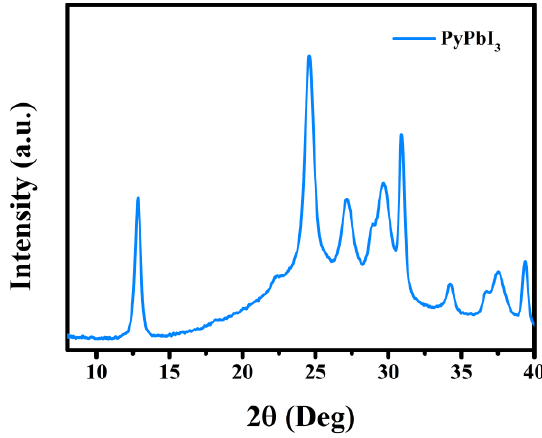
Figure 1. The schematic illustration of the PyPbI 3 film fabrication process.